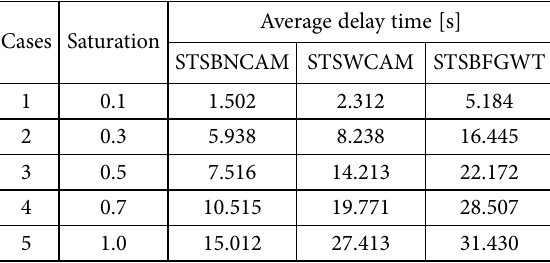
Table 7. Simulation data and comparisons Cases